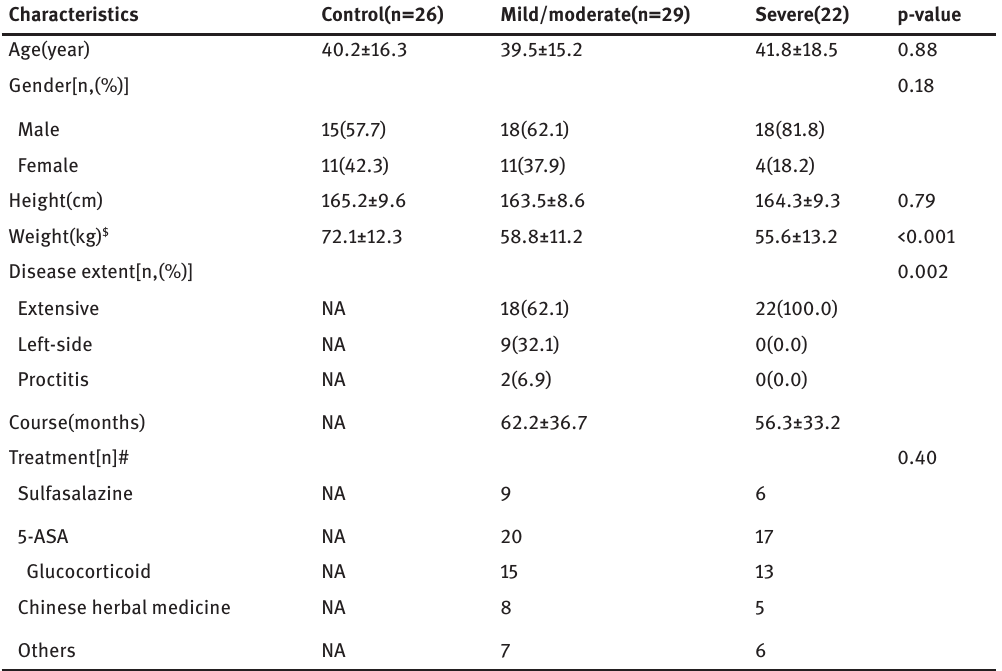
Table 1: General characteristics of the included subjects.